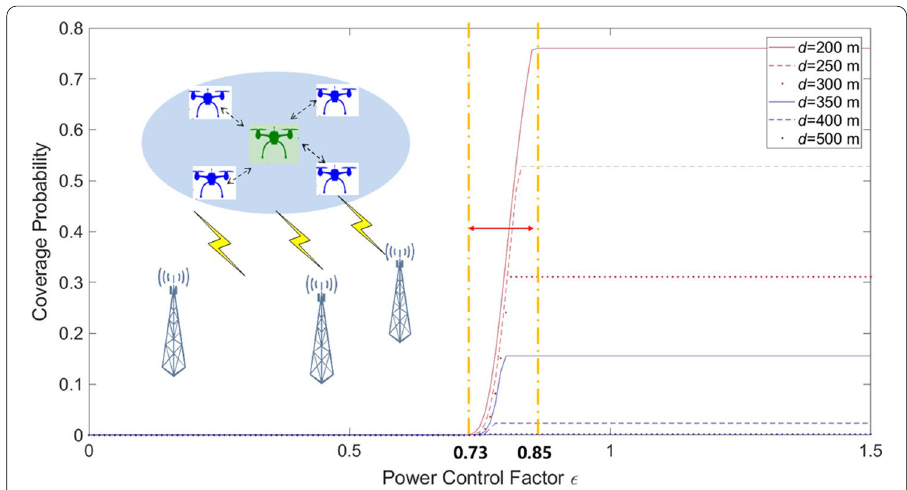
Fig. 5 Coverage probability versus power control factor